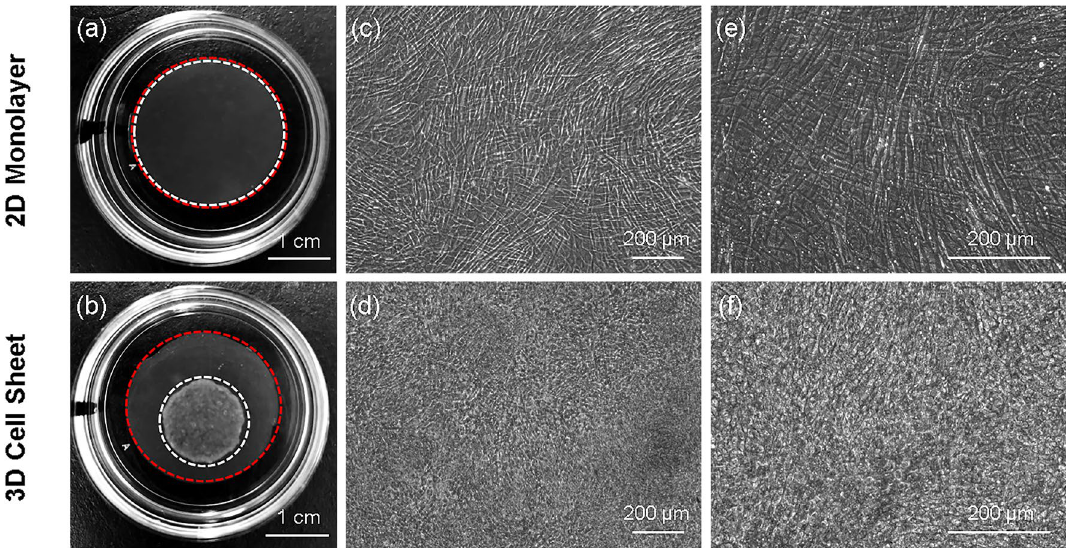
Figure 1. Microscopic cell morphology influences macroscopic tissue structure. Macroscopic image and microscopic cell morphology of hUC-MSC 2D monolayers seeded onto an insert membrane, and contracted 3D cell sheets following temperature-detachment and placement on an insert membrane. In both groups, hUC-MSCs were seeded at 41,580 cells/cm 2 initial cell densities. Macroscopic images of a ( a ) 2D monolayer (white dashed circle) on an insert membrane (red dashed circle, 24 mm diameter) and a ( b ) 3D cell sheet (white dashed circle) on an insert membrane, placed in the center of tissue-culture plastic dishes (35-mm diameter) for imaging. Morphology of hUC-MSCs in a 2D monolayer at ( c ) × 10 and ( e ) × 20 magnification, and in a 3D cell sheet at ( d ) × 10 and ( f ) × 20 magnification, observed using phase-contrast microscopy. Scale bars = 1 cm in ( a ) and ( b ). Scale bars = 200 μm in ( c ) through ( f ).